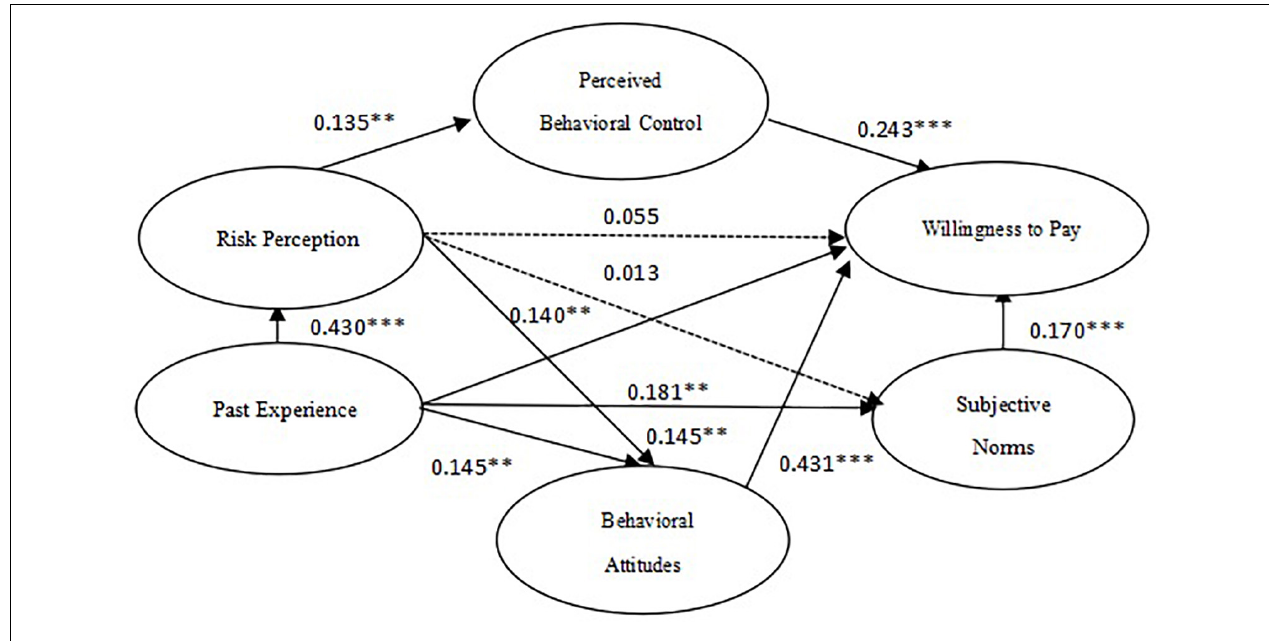
FIGURE 2 | Results of structural model. * P < 0.1, ** P < 0.05, and *** P <